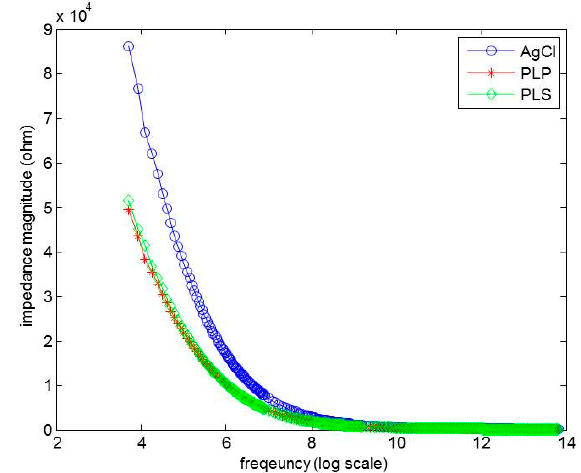
Figure 11. The impedance performance of Ag/AgCl, pencil lead powder-type, and pencil lead solid-type electrodes.